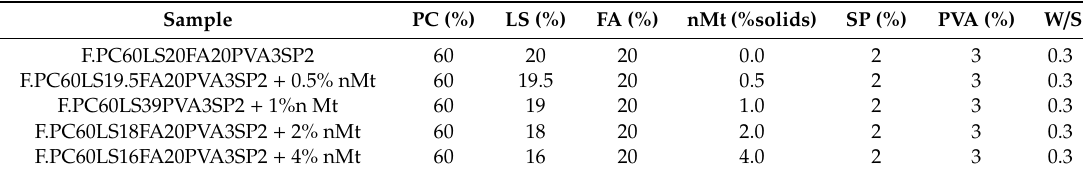
Table 1. Nano-montmorillonite (nMt)-fibre reinforced quaternary formulations—Mix proportions % by total mass of